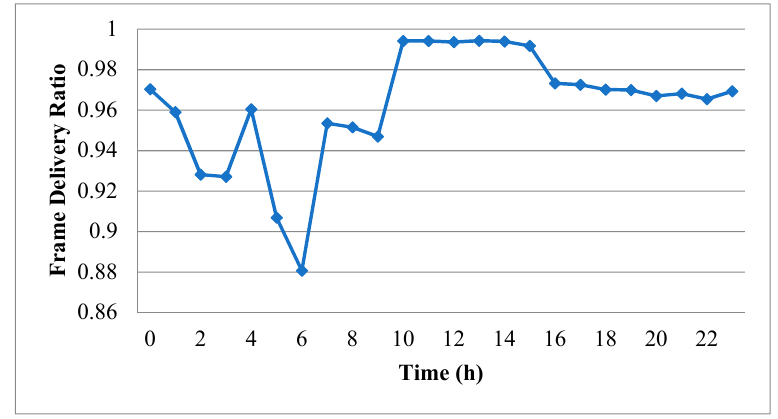
Figure 5. Frame Delivery Ratio (FDR) in every hour of the experimental measurement period.